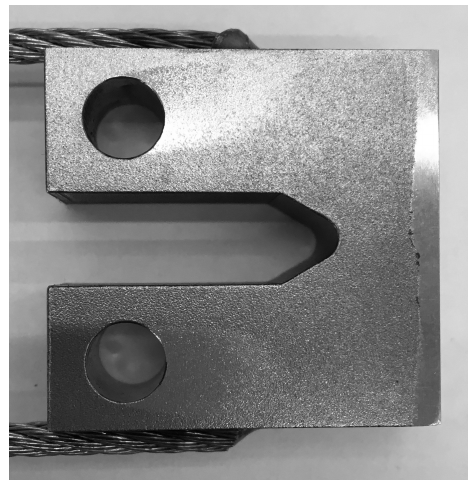
Figure 4. The blunt notch CT specimen used in the current study; image from Ref.